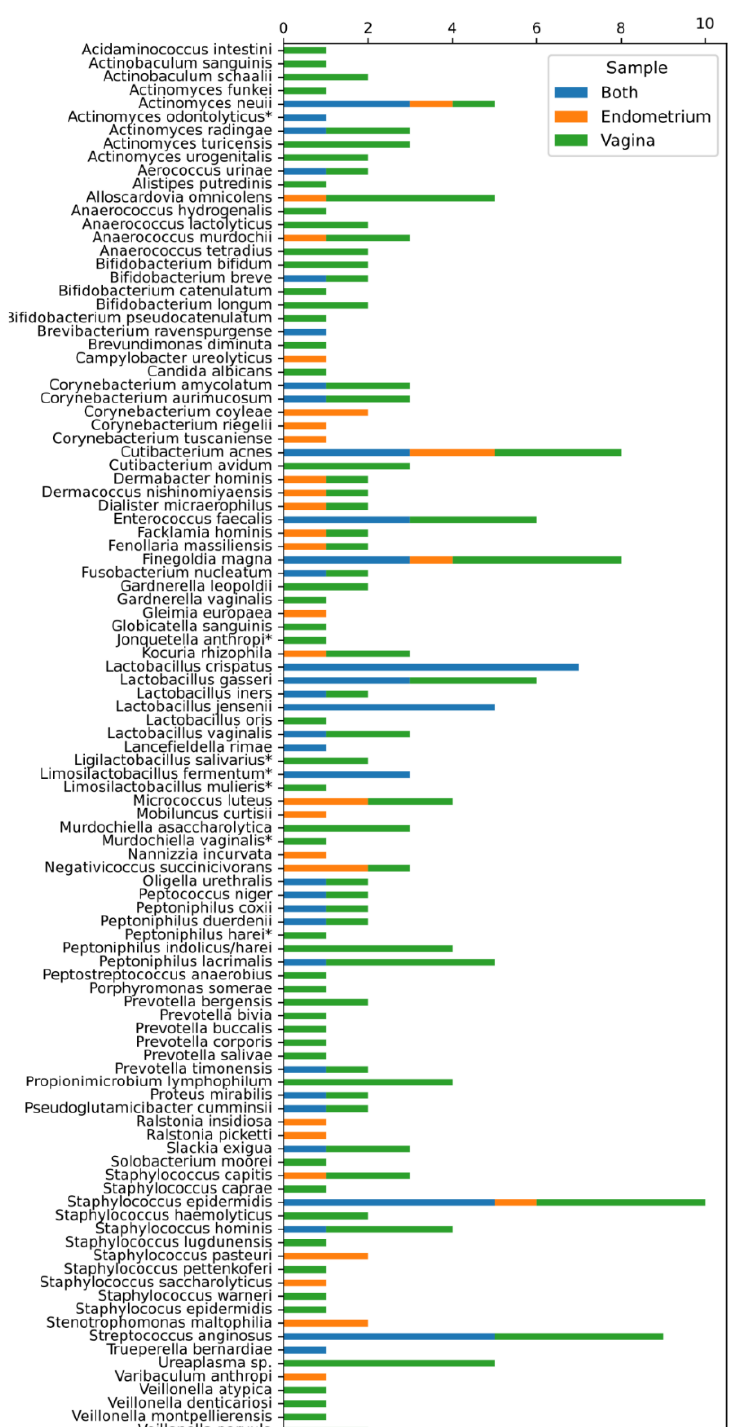
Figure 1. Different microbiota species identified in the 10 patients enrolled in the study. On the y-axis, a summary of the 103 different species found in the 10 endometrial biopsies and 10 vaginal swabs. On the x-axis, the number of times identified per participant. Orange: identified only in the endometrium. Green: identified only in the vagina. Blue: identified in both endometrium and vagina. * Species identified using 16S rRNA sequencing